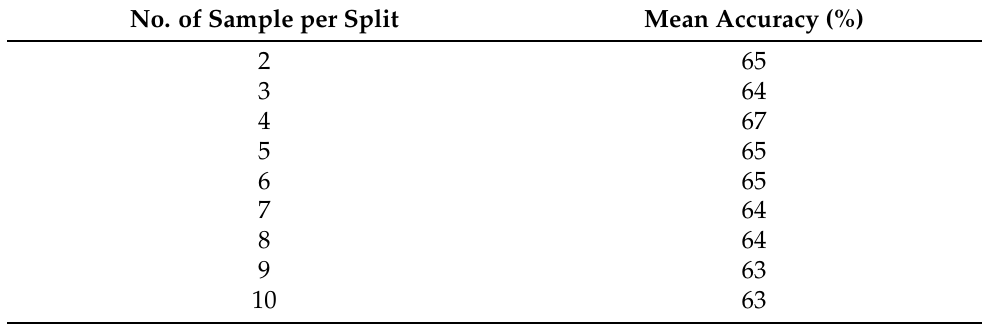
Figure 22. Nepal: Boxplot to illustrate the mean accuracy distribution by hyper-tuning the minimum number of samples per split. Table 11. Nepal: Predictive accuracy score against number of samples per split.